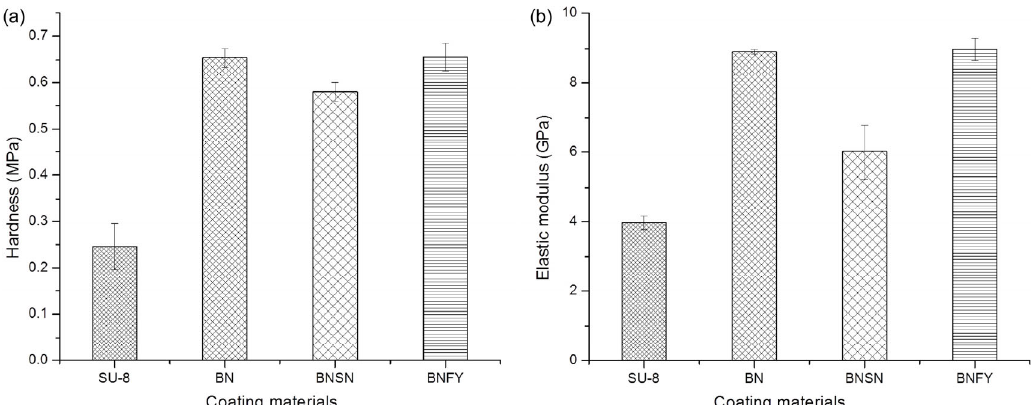
Fig. 7 Mechanical properties of SU-8 and its composite materials: (a) hardness of the coating materials and (b) elastic modulus of the coating